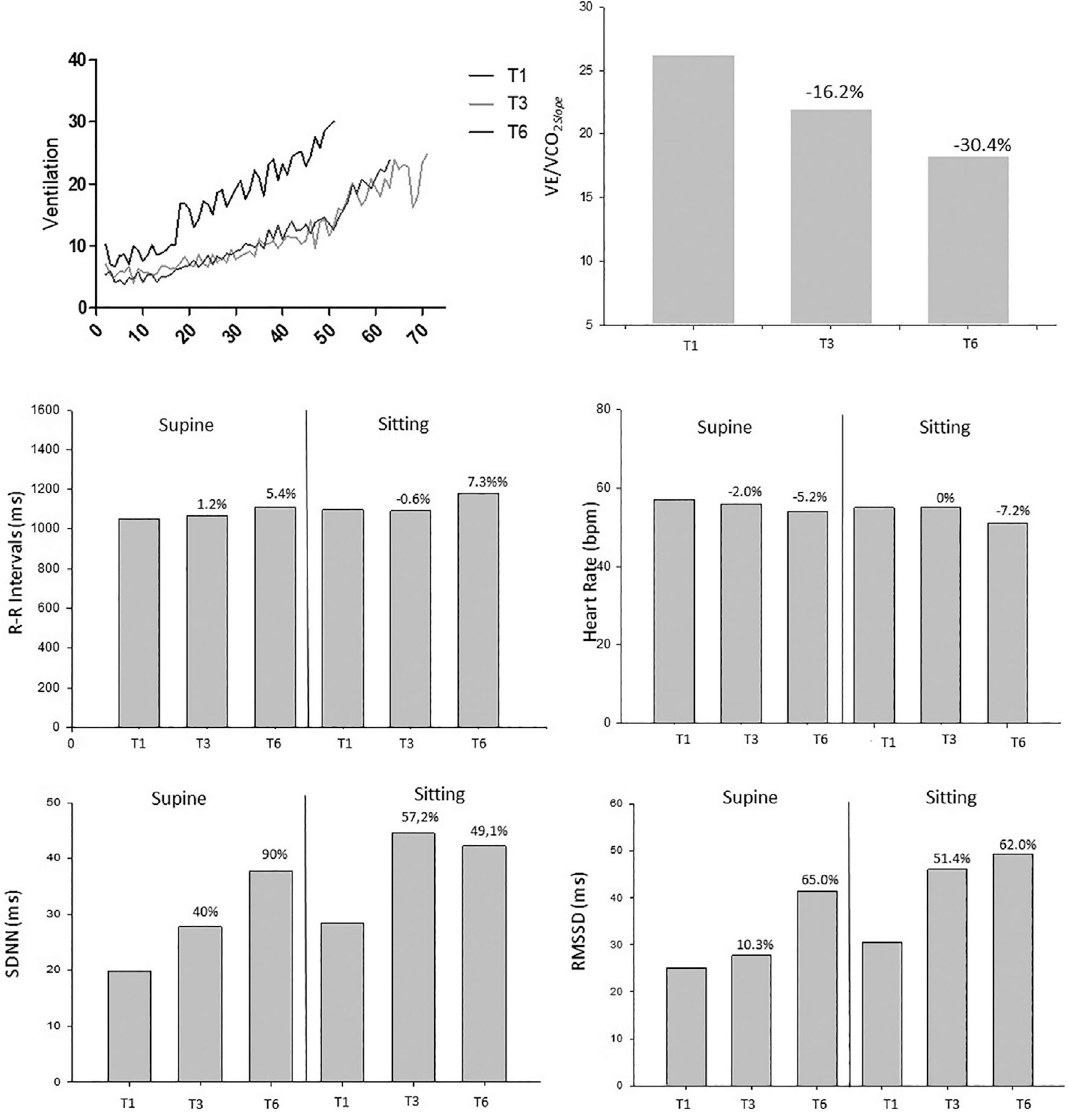
Figure 1 - Data on ventilation, ventilation efficiency, and heart rate variability from a woman from a woman with Chagas Cardiopathy throughout the intervention process in the lying and sitting position at baseline (T1), three (T3), and six (T6) months after 24-week combined physical training Legend: IRR: RR intervals; SDNN: Standard deviation of all normal RR intervals; RMSSD: Square root of the mean of the square of the differences between the adjacent normal RR intervals; NN50: Represents the adjacent RR intervals with a difference in duration greater than the 50s; pNN50: Percentage of adja- cent RR intervals with a difference in duration greater than 50s; SD1: Scattering of points perpendicular to the identity line; SD2: Scattering of points along the identity